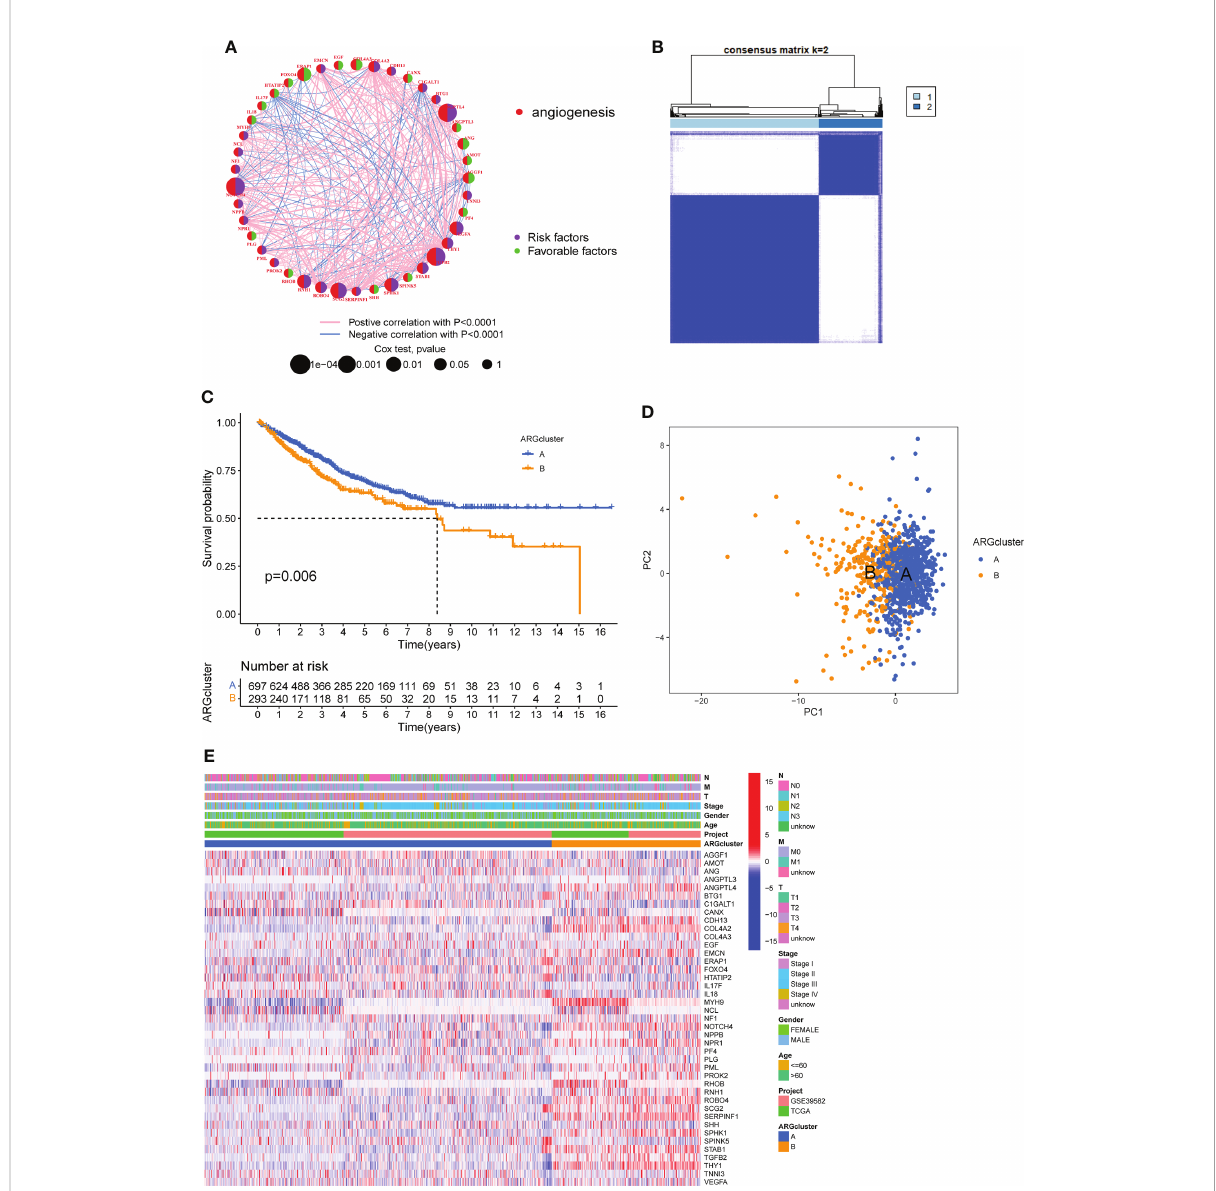
FIGURE 2 Formation of angiogenesis-related genes clusters (ARGclusters). (A) The network showing the correlation of ARGs in COAD. (B) All samples from TCGA-COAD cohort and GSE39582 cohort were divided into 2 clusters using consensus clustering algorithm (k = 2). (C) Kaplan-Meier curves show the different overall survival (OS) between two ARGclusters. (D) Principal component analysis (PCA) showed signi fi cant differences between the two ARGclusters. (E) Heatmap showed the differences between two clusters in clinical information and ARGs